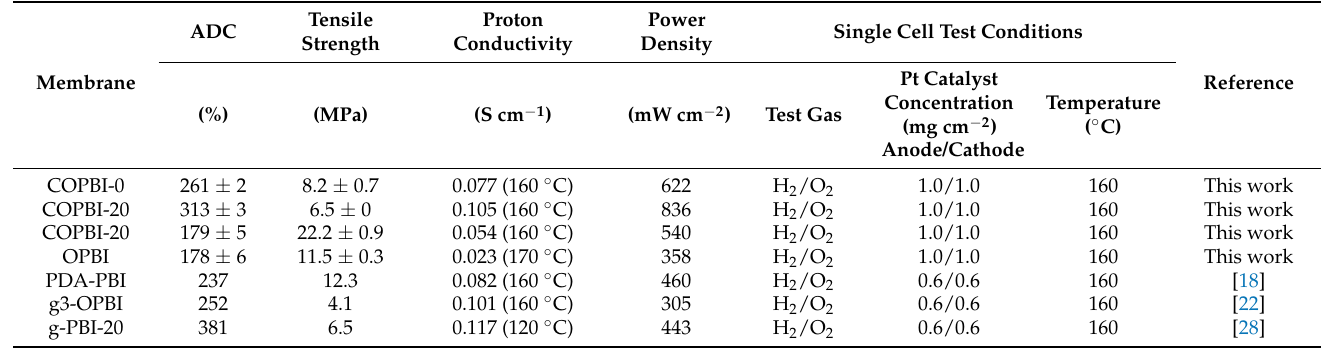
Table 2. Comparison of the performance of PA-PBI